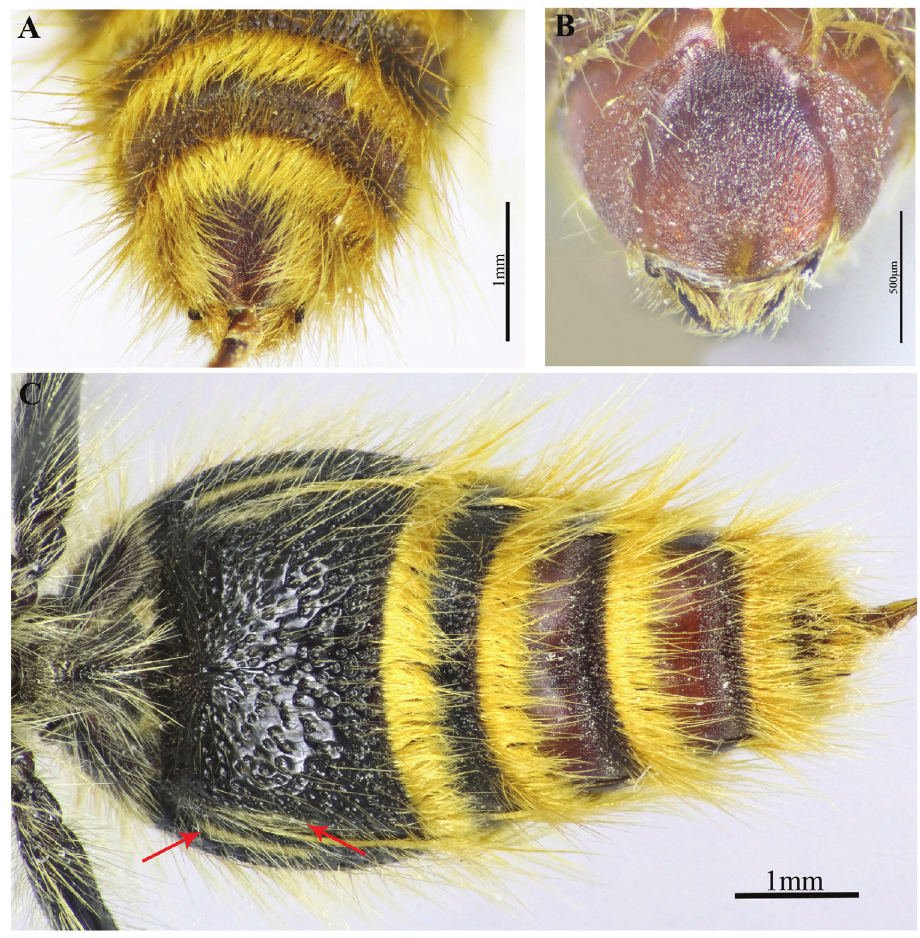
Figure 9. Pseudophotopsis aurea (Klug) (Female) A T4–T6, dorsal view B T6 (after removing setae sur- rounding pygidial area) C metasoma, ventral view (felt lines on T2 and S2